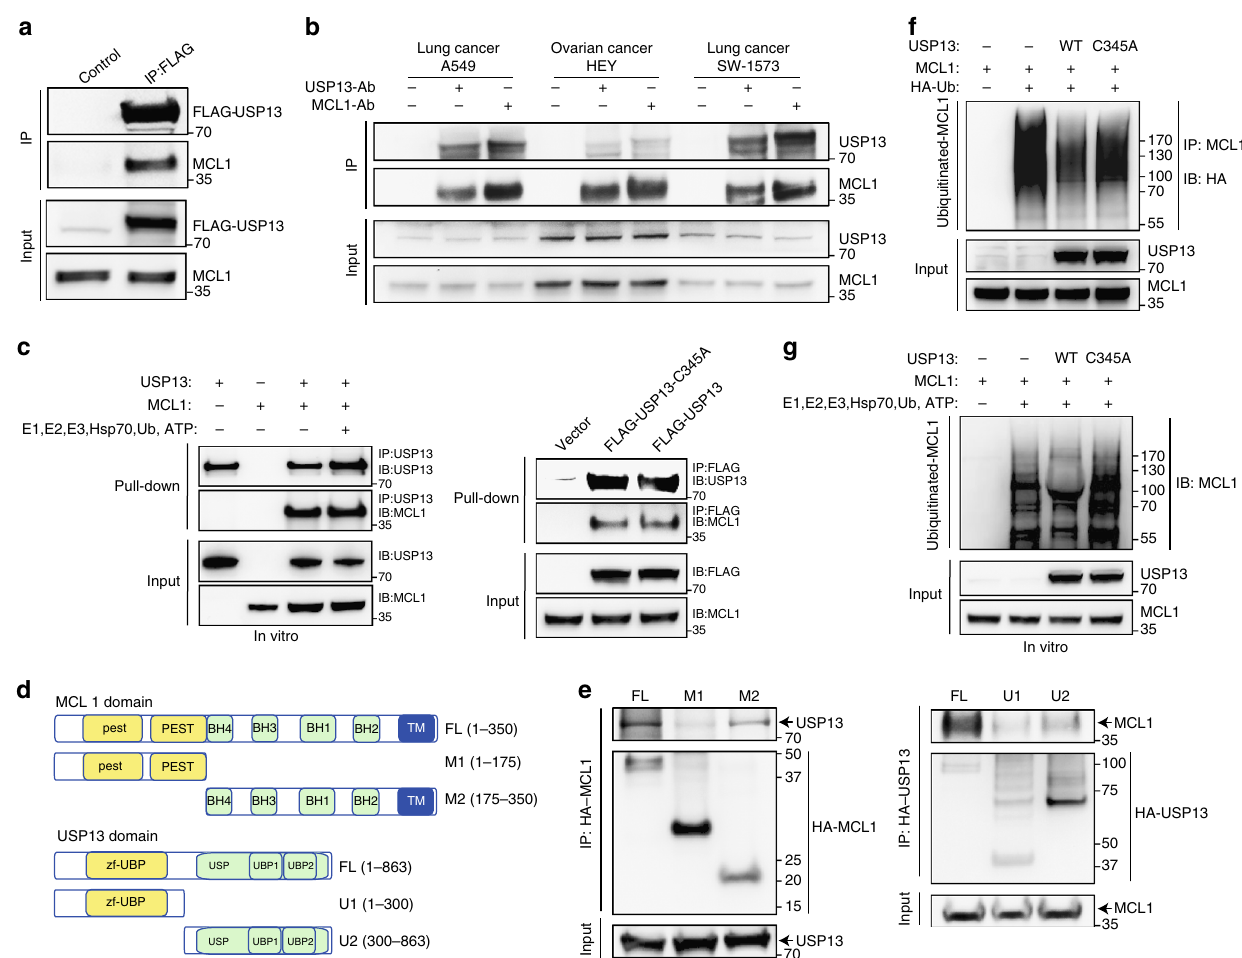
Fig. 4 USP13 interacts with and deubiquitinates MCL1. a 3 × FLAG-tagged USP13 was transfected into HEK293T cells. Cells were treated with MG-132 for 8 h and USP13 was immunoprecipitated using an anti-FLAG antibody. Co-immunoprecipitated MCL1 was detected using an anti-MCL1 antibody. b Endogenous USP13 and MCL1 were immunoprecipitated from A549, HEY and SW-1573 cells using an anti-USP13 antibody or an anti-MCL1 antibody respectively. Co-immunoprecipitated endogenous MCL1 or USP13 was analyzed by western blotting. c Left: Puri fi ed His-MCL1 and His-USP13 proteins were co-incubated and immunoprecipitated with an anti-USP13 antibody. Co-immunoprecipitated MCL1 was detected using an anti-MCL1 antibody. Right: FLAG- USP13 or FLAG-USP13-C345A was transfected into HEK293T cells and immunoprecipitated using an anti-FLAG antibody. Co-immunoprecipitated MCL1 was detected using an anti-MCL1 antibody. d A schematic of full-length USP13 (FL), full-length MCL1 (FL) and their deletion mutants (M1, M2, U1, U2). e USP13 was co-transfected with the MCL1 deletion mutants, and MCL1 was co-transfected with the USP13 deletion mutants. Interactions were analyzed using the co-immunoprecipitation assay. f MCL1 was co-transfected with FLAG-USP13 or the FLAG-USP13-C345A mutant, with or without HA-ubiquitin. The ubiquitinated MCL1 was measured using an in vivo ubiquitination assay. g Puri fi ed His-MCL1 and His-USP13 proteins were co-incubated in the ubiquitination system. The ubiquitinated MCL1 was measured using an in vitro ubiquitination